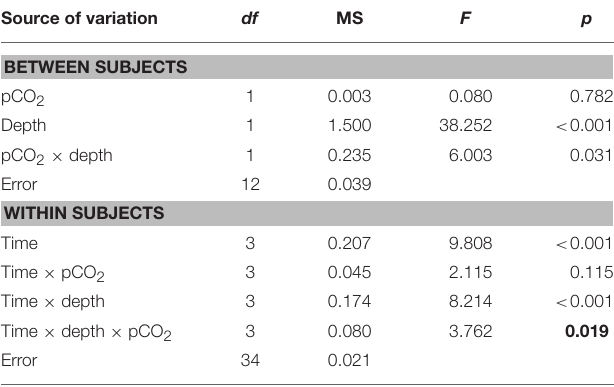
TABLE 2 | Results of a two-factor RM ANOVA. Source of